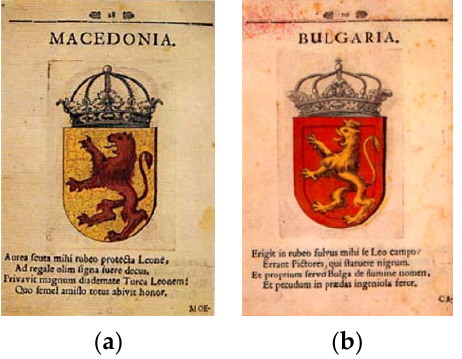
Figure 20. ( a ) CoA of Macedonia from the Stematographia by Vitezovich. ( b ) CoA of Bulgaria from the Stematographia by Vitezovich.